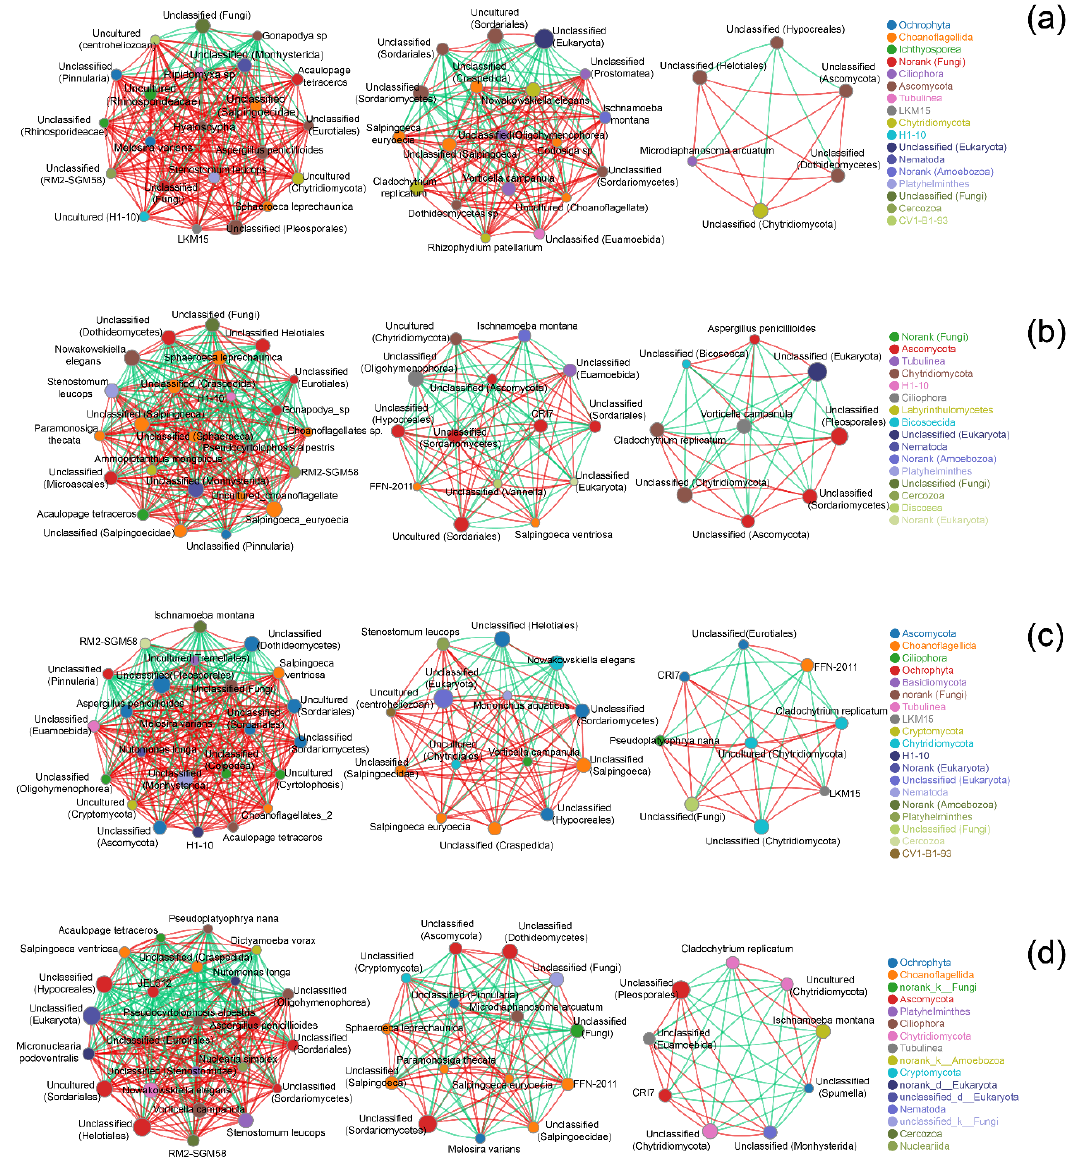
Figure 3. Co-occurring fungi at the species level in the control (N treatment) ( a ), artificial light at night (ALAN) treatment ( b ), N-Cd treatment ( c ), and A-Cd exposure ( d ). Sizes and colors of the nodes represent the relative abundance of the fungi. Solid lines in red and green denote positive and negative correlations, respectively. The width reflects the strength of the correlation.